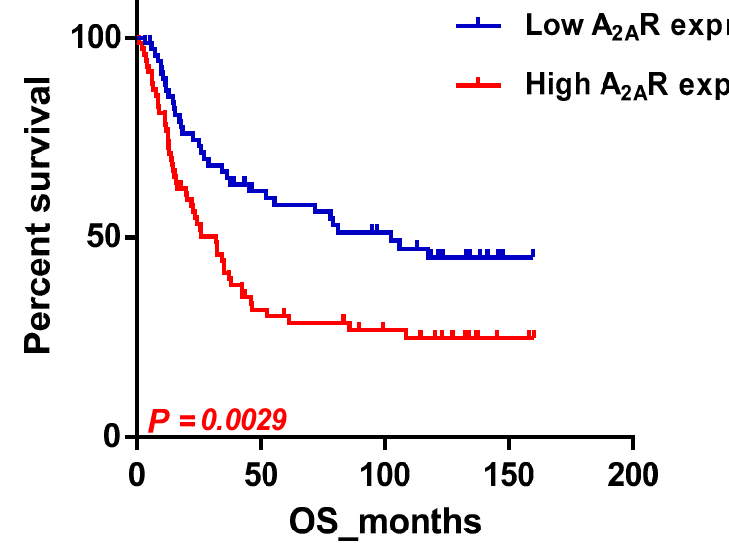
Figure 3. Survival curve according to A 2A R expression, indicating poor survival in CGGA males. Patients were divided into two groups based on median A 2A R expression. Blue curve represents patients with low expression, and red curve represents high A 2A R expression.